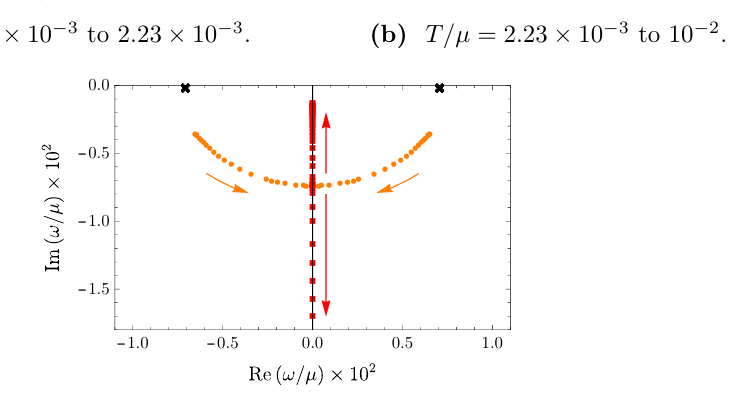
two poles met on the imaginary axis but with no purely imaginary poles above them.